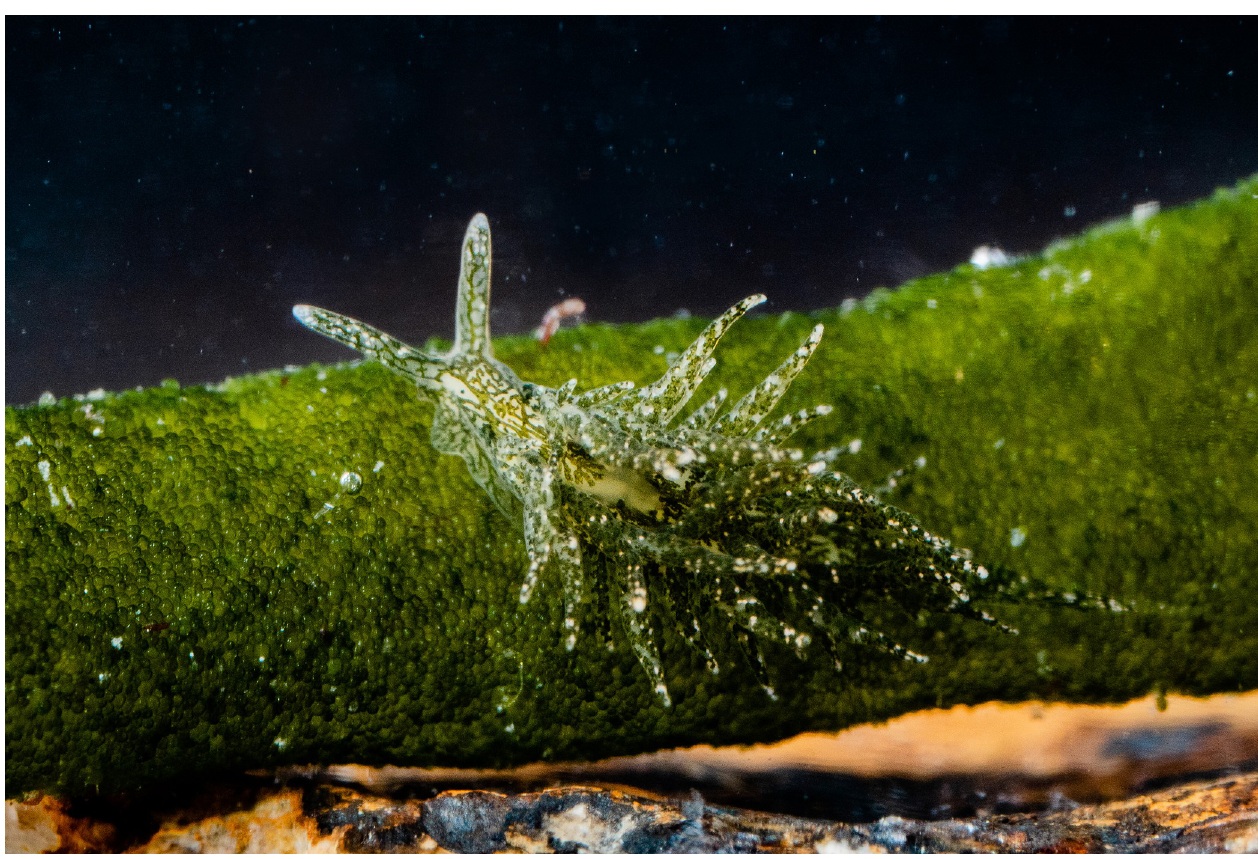
Fig 1. Crypsis in sacoglossan sea slugs. The sea slug Placida dendritica retains short-term, nonfunctional kleptoplasts that allow the sea slug to blend with the environment and avoid predation.